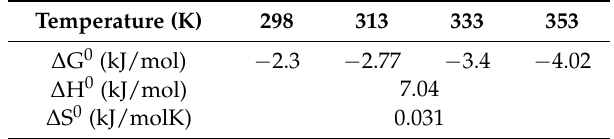
Table 3. Thermodynamic parameters for BZC adsorption onto MSN.